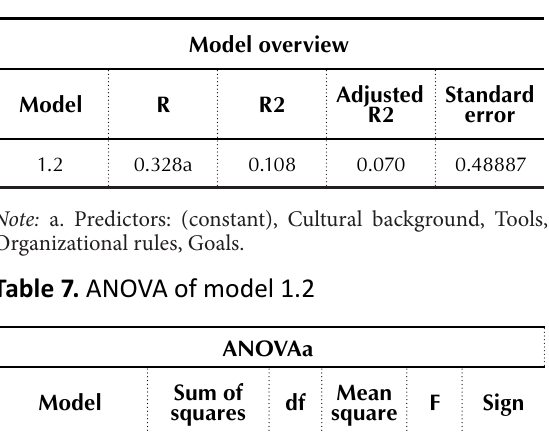
Table 6. Overview of model 1.2